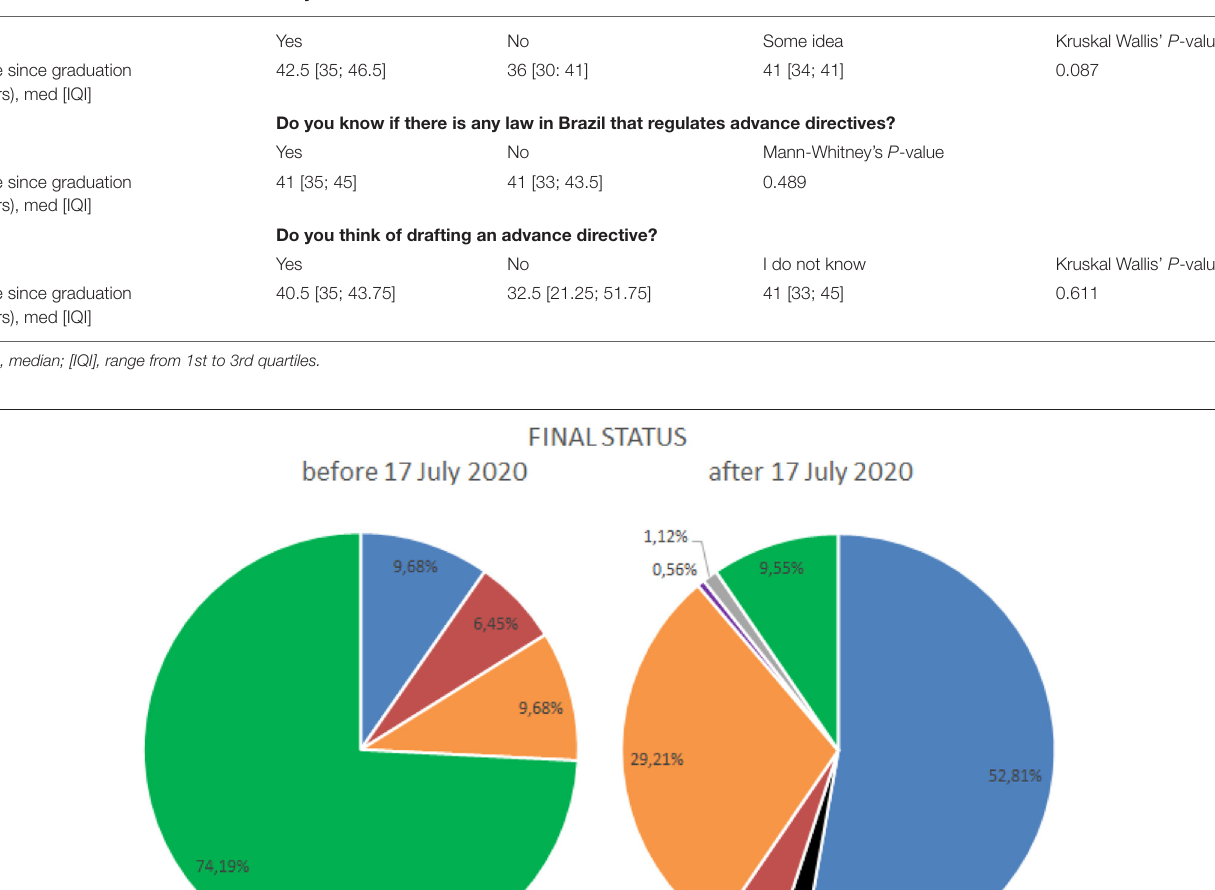
TABLE 3 | Comparison of the time since graduation (years) of participants according to advance directives questionnaire responses. Do you know what an advance directive is?